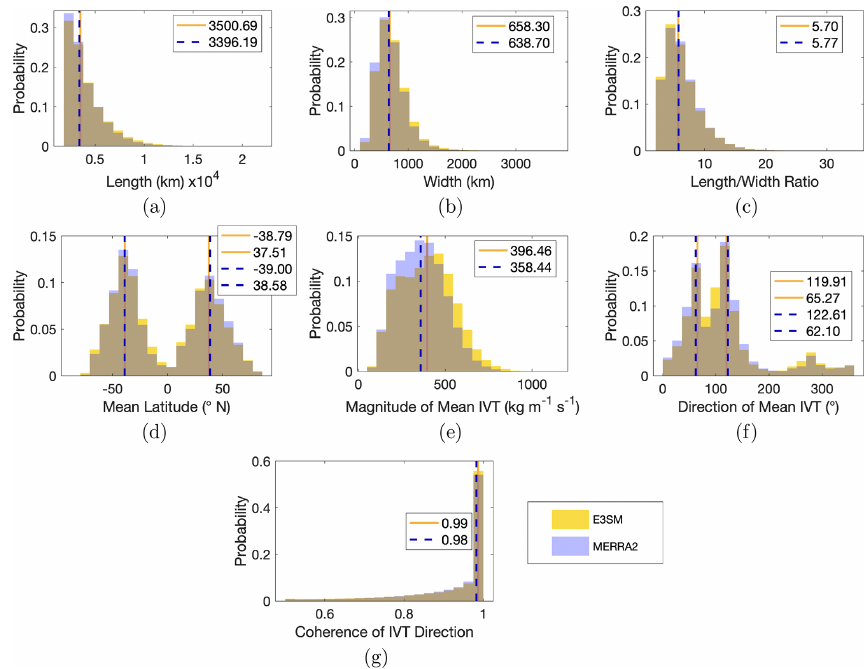
Figure 4. Distributions of a variety of AR characteristics in E3SM and MERRA2. The yellow bars and solid line (median) are for E3SM and the blue bars and dotted line (median) are for MERRA2. Two sets of lines indicate hemispheric median values.